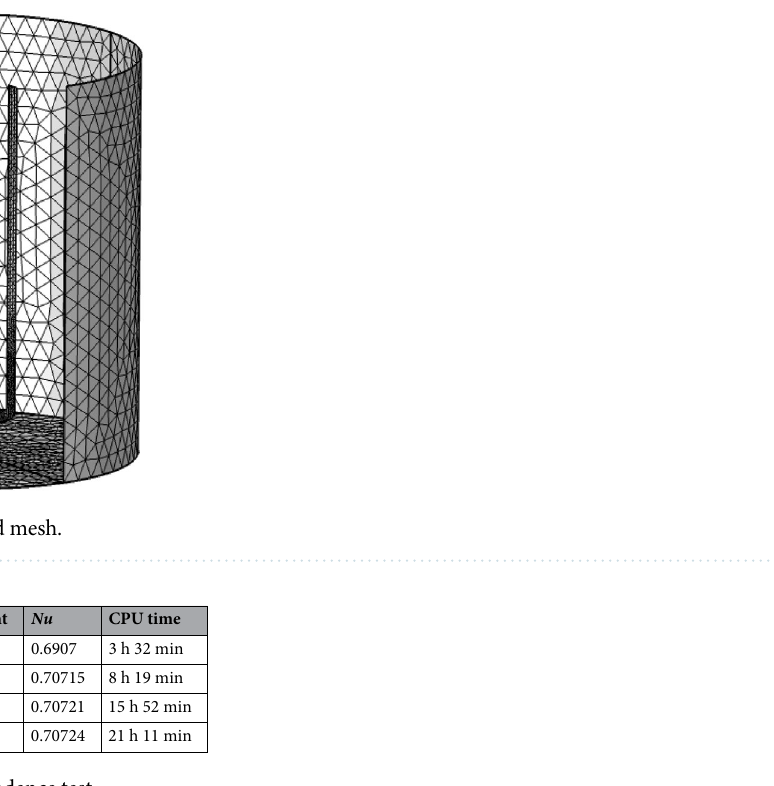
Table 2. Mesh independence